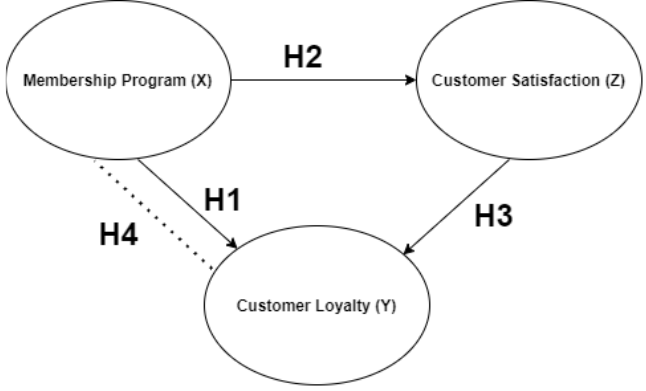
Figure 1: Research Framework; Source: Processed Researcher